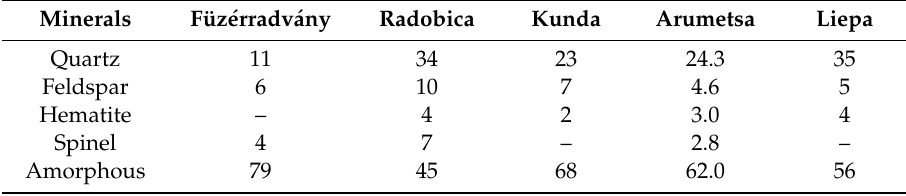
Table 3. Mineral composition of the investigated clays after firing at 1100 ◦ C (in mass%)